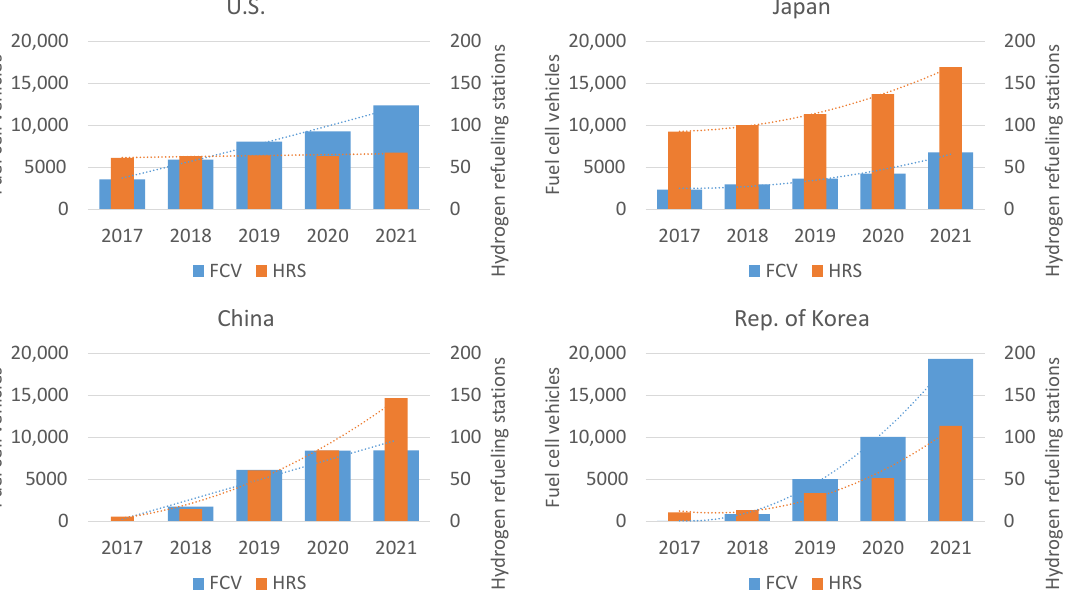
marked with dots in the figure. As the realized numbers are relatively low compared to the target numbers, in most of the cases third-degree polynomials are required to draw the trend lines combining the present numbers with the plans. One exception is the case for HRSs in South Korea. As the targets are defined for many more years, a second-degree polynomic function can describe the curve there well. Another remarkable deviation in the general trends is for HRSs in Japan. As the end target is already defined for 2030 and is on the same order of magnitude as the current numbers, the present HRS numbers are also fairly apparent for Japan.